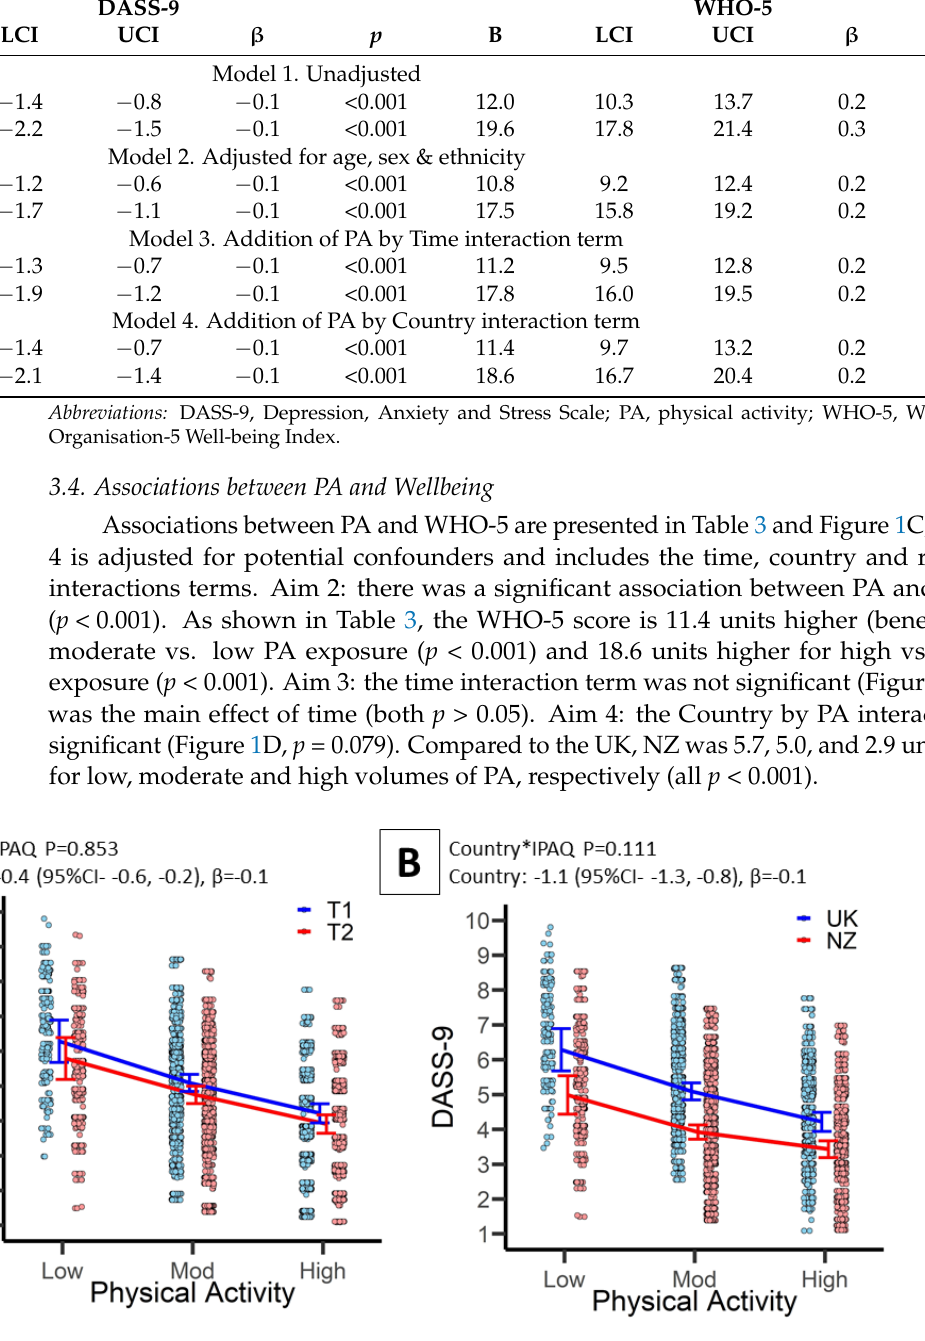
Table 3. Associations between subjectively measured physical activity (IPAQ-SF) with mental health (DASS-9) and well-being (WHO-5). Data presented are linear mixed-effects model esti- mates. Specifically, simple effects for low vs. moderate- and low vs. high-physical activity. Data points = 6726 (1333 UK * 2 time points, 2030 NZ * 2 time points). DASS-9 WHO-5 Model 1. Unadjusted